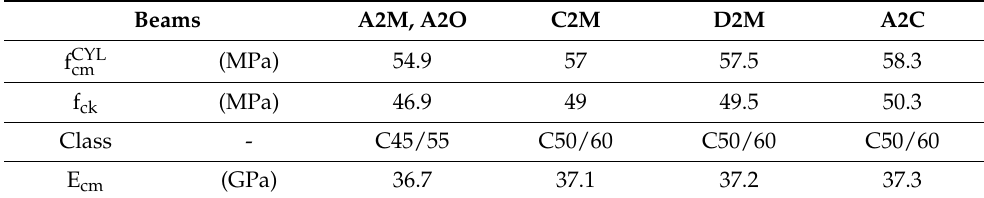
Table 5. Concrete class.